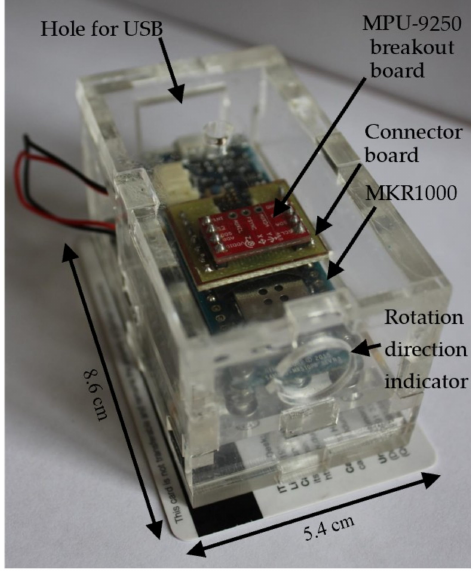
Figure 5. View of sensor in clear acrylic case. The sensor was placed on top of a standard-sized ID card to give an idea of